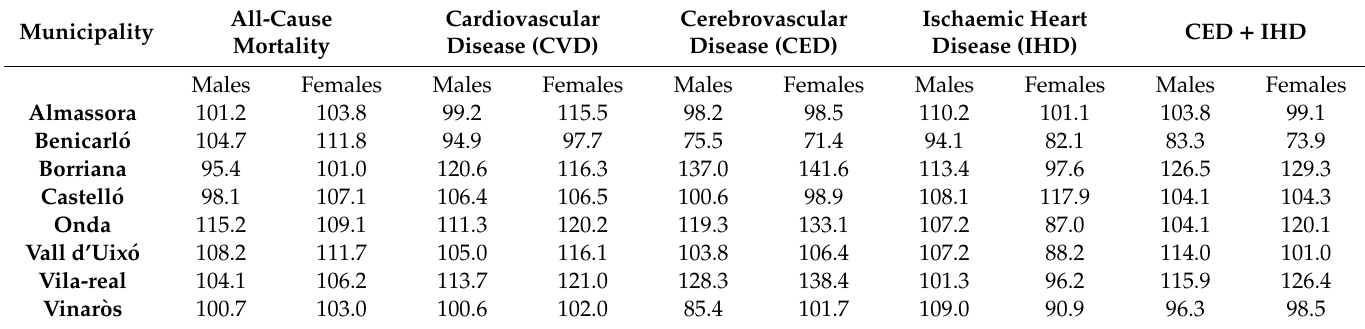
Table 3. Smoothed standardized mortality ratios (SMRs): males and females (Castell ó n, 1991–2011